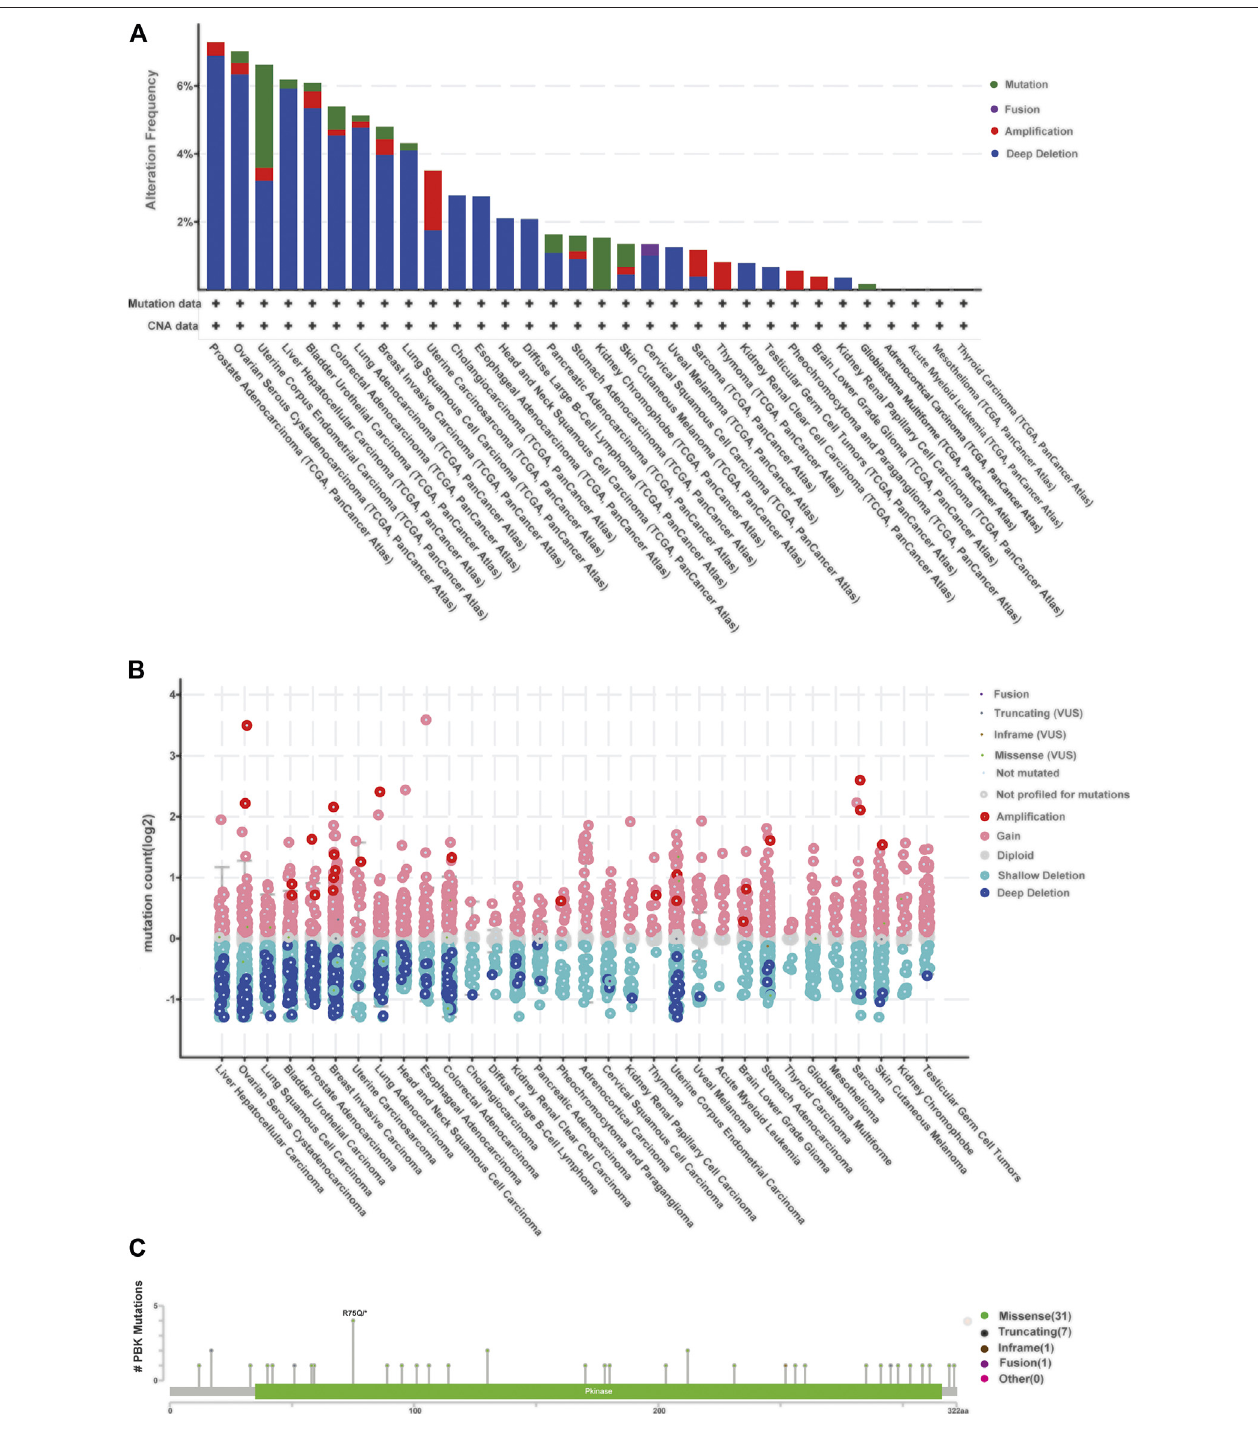
FIGURE 7 | | Relationship between PBK and mutation in human cancers based on the cBioPortal database. (A) PBK mutation level in pan-cancer; (B) mutation count of PBK in different cancer types; (C) mutation diagram of PBK in different cancer types across protein domains.